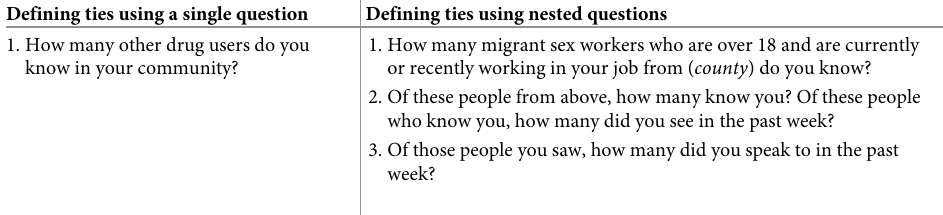
Table 2. Examples of different strategies for defining ties among population members used to elicit reported net- work degree from respondents. Defining ties using a single